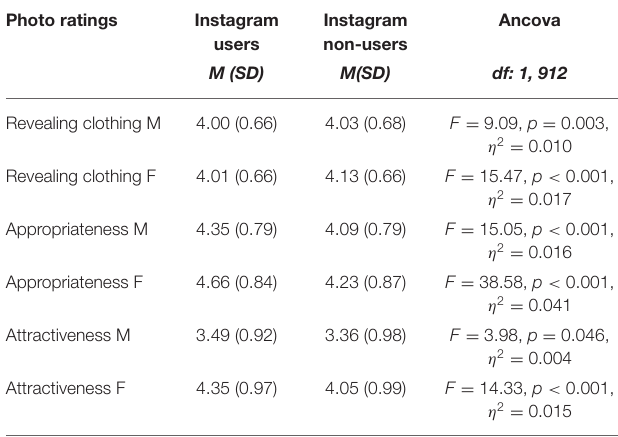
Frontiers in Psychology |